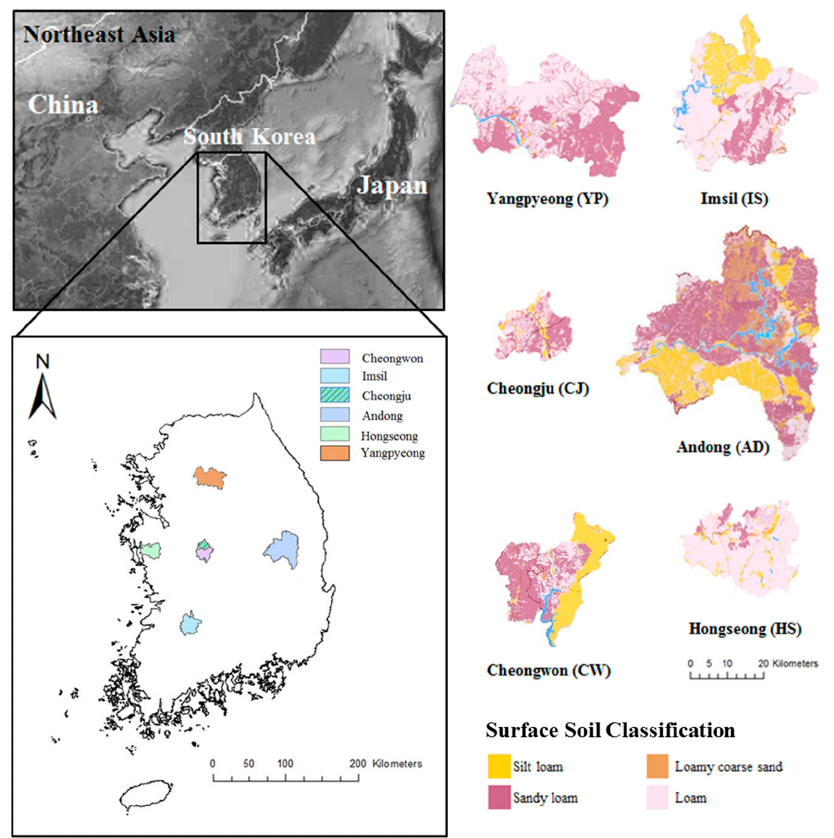
Figure 1. Validation basins in Northeast Asia and surface soil classification. Table 1. Characteristics of the study areas.